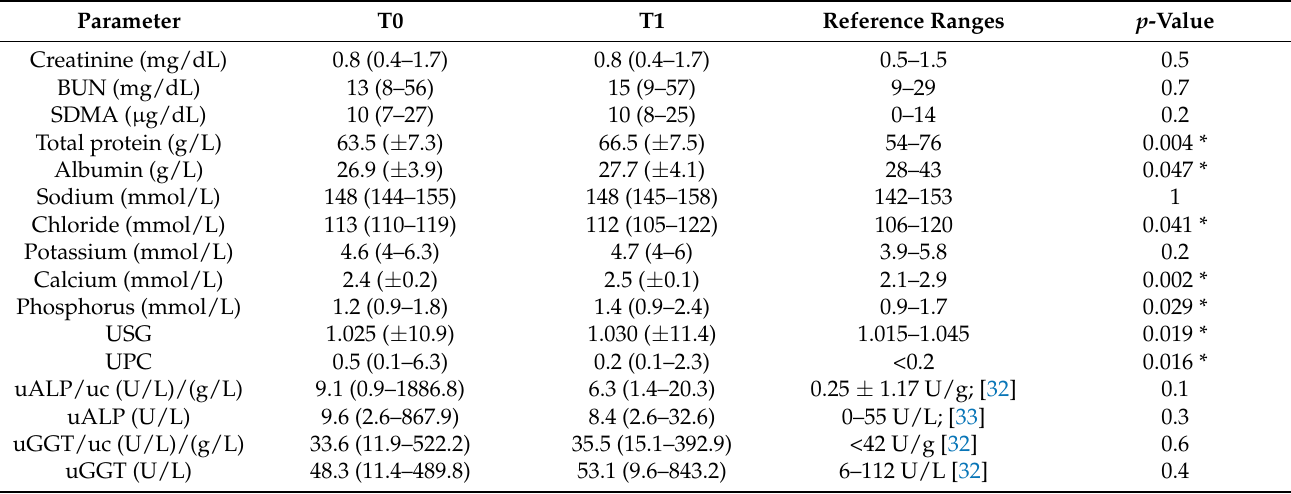
Table 2. Results of selected biochemical and urinary parameters of 22 dogs before (T0) and after (T1) IVIC administration.